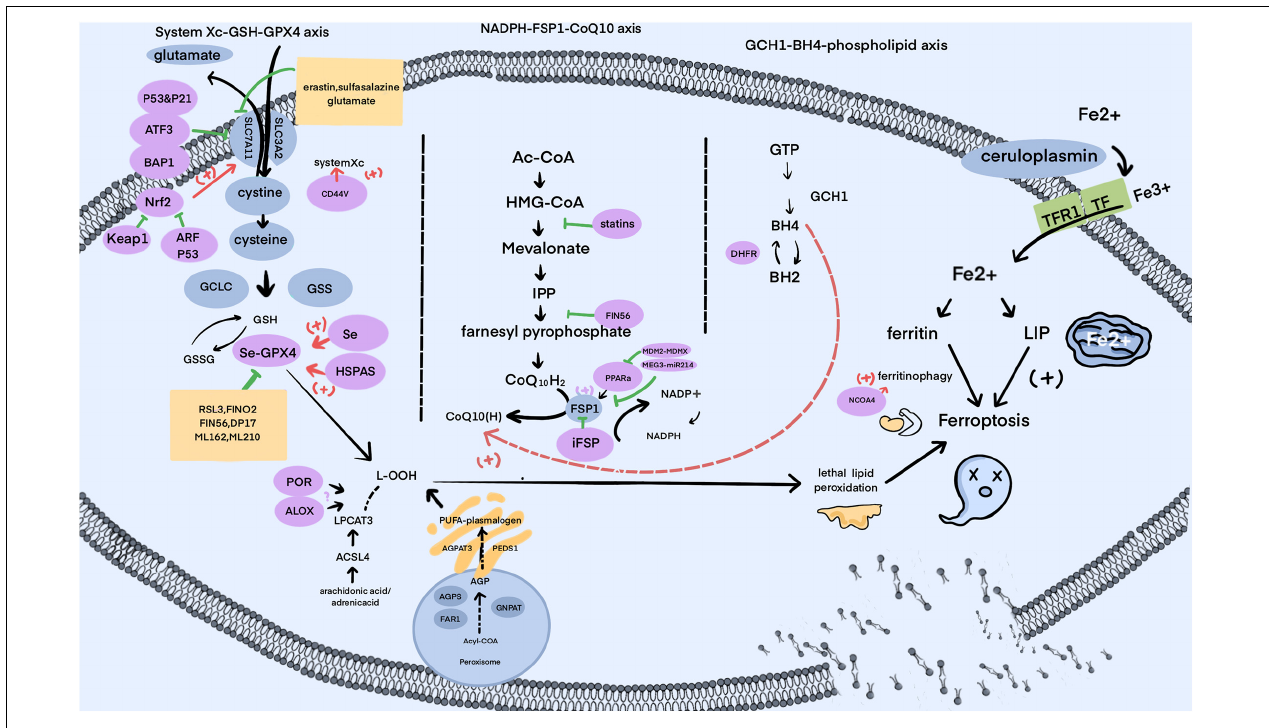
FIGURE 2 | The signal pathways of